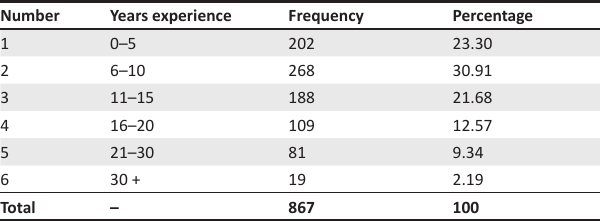
TABLE 4: Years experience within the organisation. Number